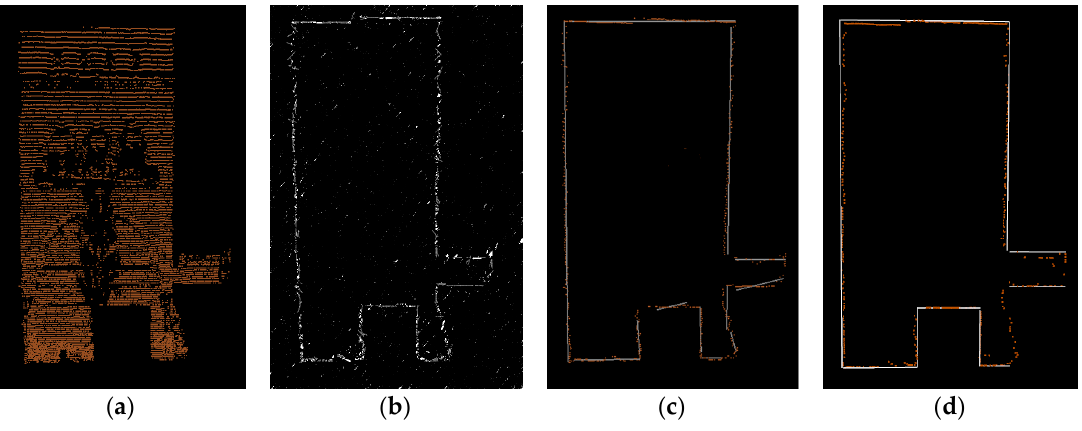
Figure 8. Line segments fitting for building patch: ( a ) projected points; ( b ) boundary points; ( c ) fitting lines using conventional least square method; and ( d ) fitting lines using regularity constraints.